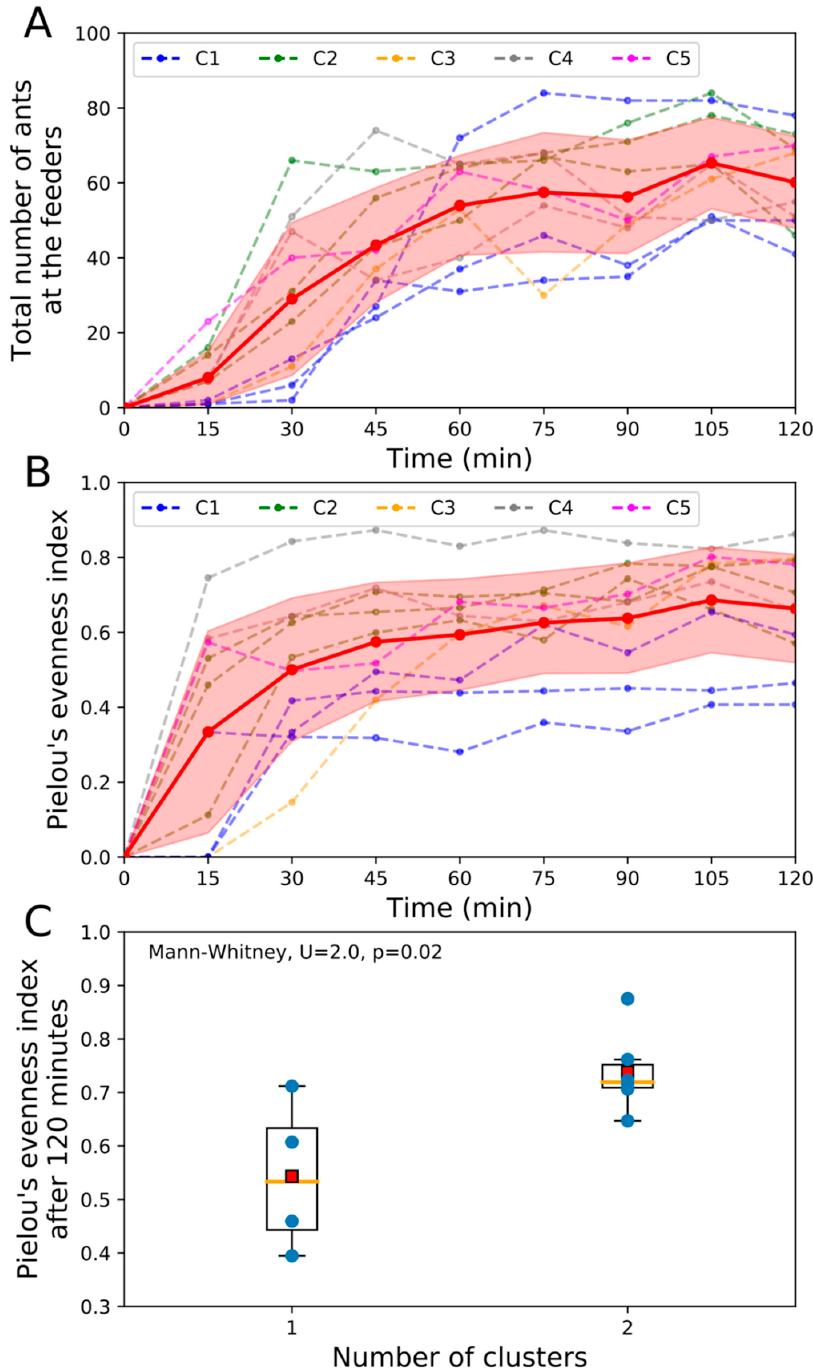
Figure 2. Exploitation dynamics of food sources . ( A ) Total number of ants present on the food sources as a function of time. ( B ) Pielou’s evenness index’s values as a function of time. Dashed lines and full circles represent the dynamics of the number of ants at the food sources for each colony (in blue (Colony C1), green (C2), yellow (C3), grey (C4) and pink (C5). Dashed lines of the same colour represent the multiple observations made on the same colony. The mean total numbers of feeding ants that were averaged over all observation sessions are represented in red (circles and line) and standard deviation in red shading. ( C ) Influence of the number of clusters on the Pielou’s evenness Index measured at the end of the experiment. For each boxplot, the red square and the orange line represent the mean and the median of the data distribution, respectively.